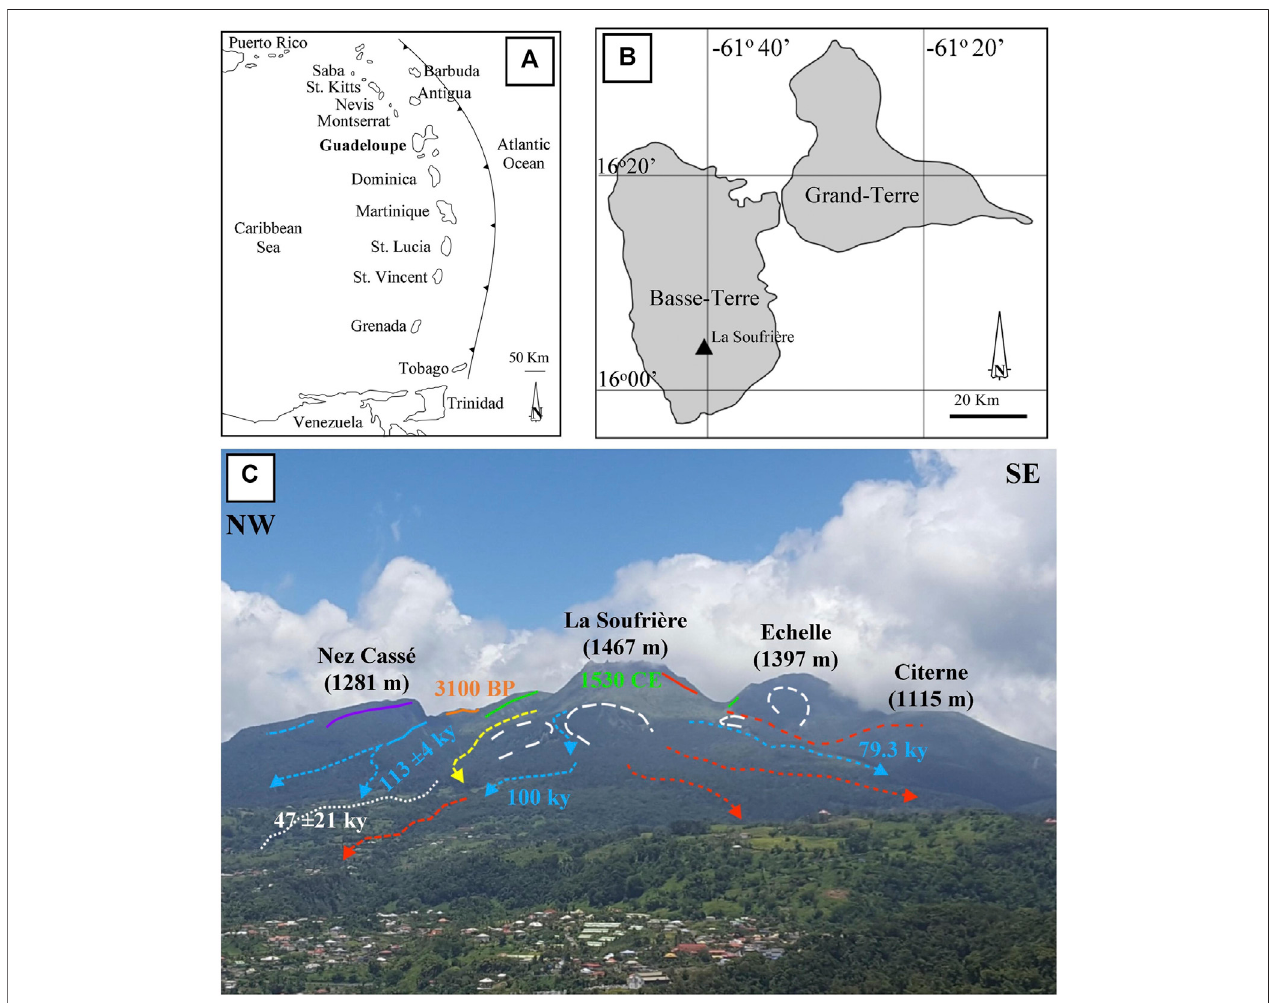
FIGURE1|(A) Aschematicmap showing theLesser Antilles inrelation tothesubduction zone position where theAtlantic plate moves underthe Caribbean plate. GuadeloupeislocatedintheinthecentralLesserAntilles.(AdaptedfromAllardetal.,2014;Pichavantetal.,2018). (B) SchematicmapofGuadeloupewhichismadeup of two islands: Grand-Terre associated with the older, inactive, outer arc and Basse-Terre associated with the active inner arc. La Soufrière de Guadeloupe, the current active vent, is located in south Basse-Terre. (Adapted from Allard et al. (2014) and Pichavant et al. (2018). (C) Annotated photo cross-section (Photo: